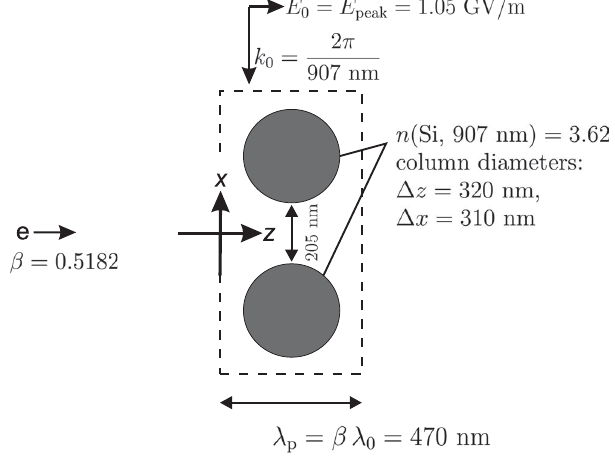
FIG. 3. Example parameters used for calculation, based on Ref.